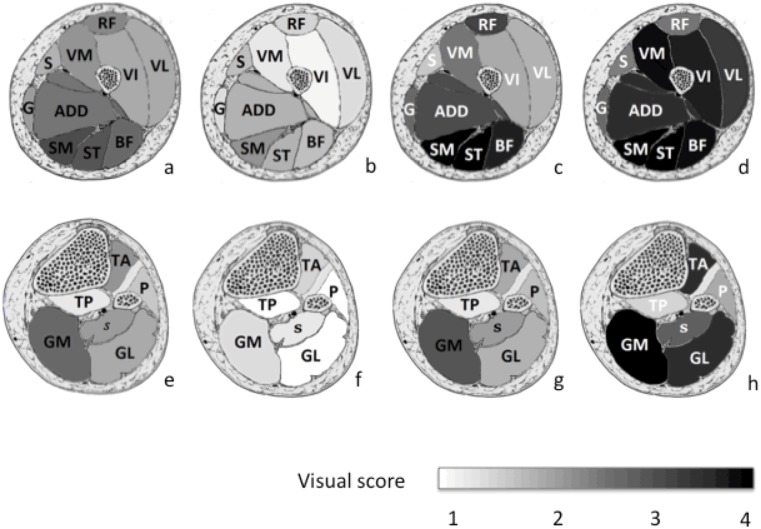
Mean visual scores for the fatty infiltration in each muscle of the lower limb.a: Thigh muscles for the whole group of patients, b: thigh muscles for T1 sub group, c: thigh muscles for T2 sub group, d: thigh muscles for T3 sub group, e: leg muscles for the whole group of patients, f: leg muscles for L1 sub group, g: leg muscles for L2 sub group, h: the leg muscles for L3 sub group. Legs: GL = Gastrocnemius lateralis, GM = Gastrocnemius medialis, P = Peroneus, S = Soleus, TA = Tibialis anterior, TP = Tibialis posterior. Thighs: ADD = Adductors; BF = Biceps Femoris; G = Gracilis; R = Rectus Femoris, S = Sartorius, SMM = Semimembranosus, SMT = Semitendinosus, VI = Vastus intermediaris, VL = Vastus lateralis, VM = Vastus medialis.